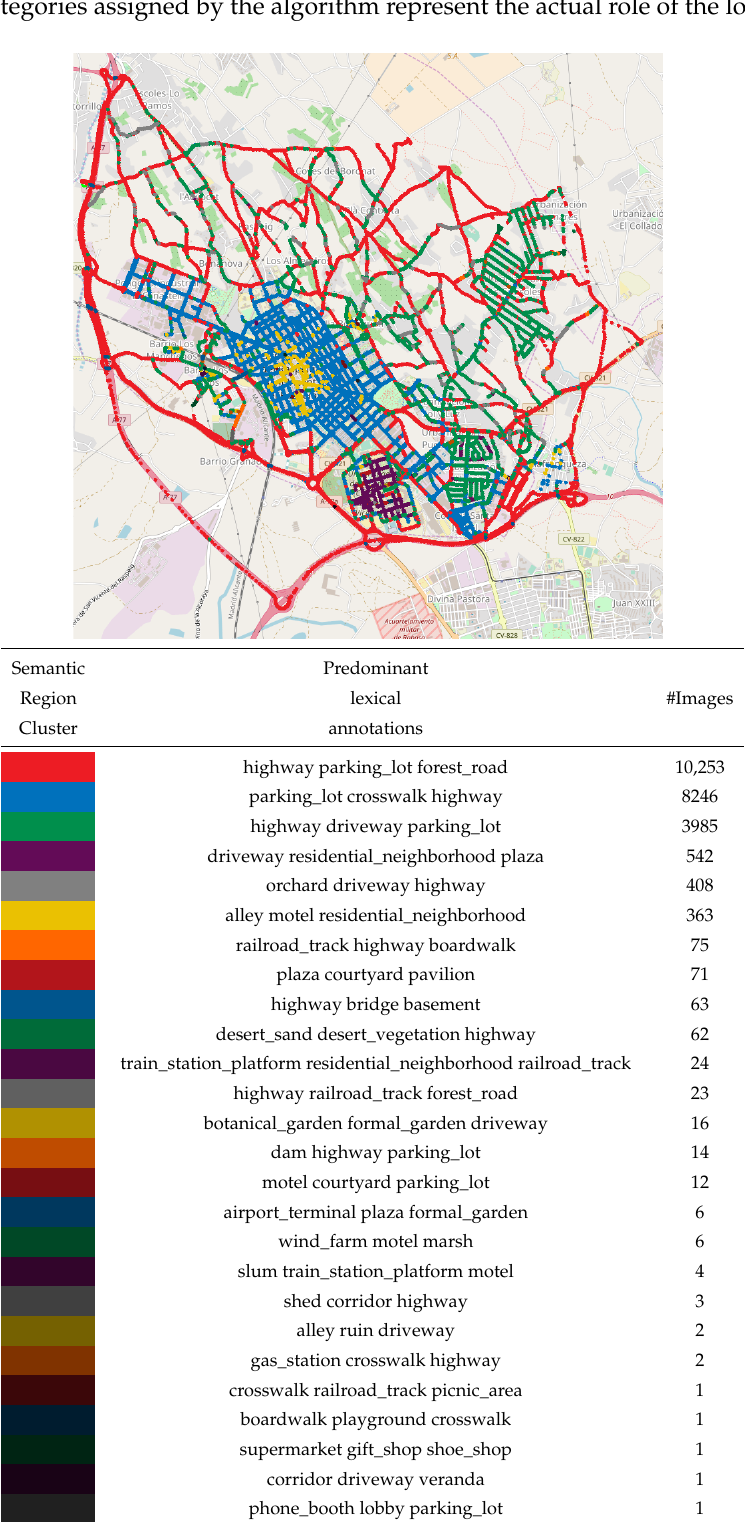
Figure 10. Semantic clusters generated with the combination Average-BrayCurtis-0.6, producing 26